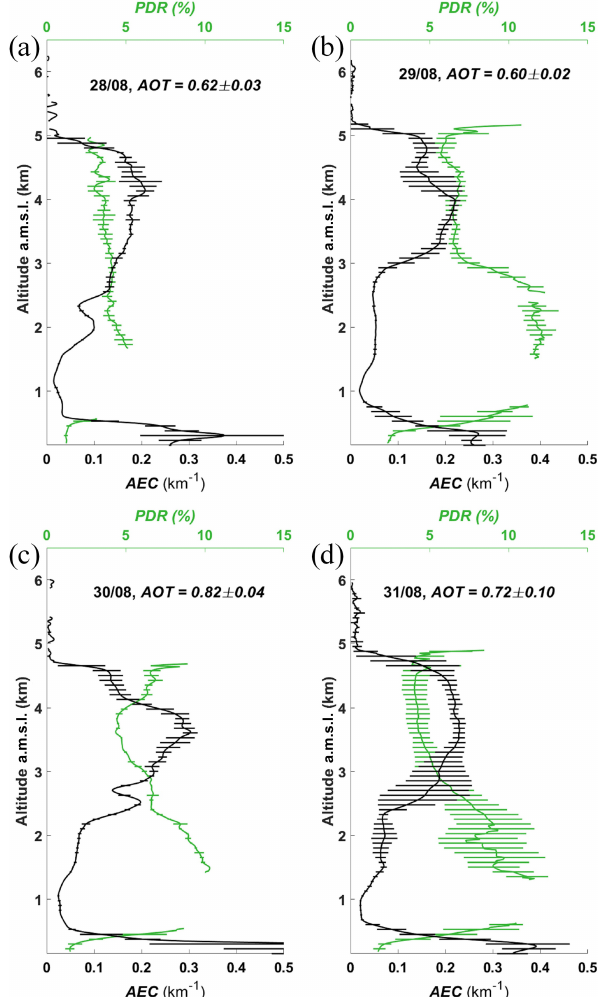
Figure 4. Vertical profiles of the AEC and PDR at 355nm with their uncertainties (horizontal bars) for period P 2 on (a) 28 (10:30– 12:30UTC), (b) 29 (17:30–22:50UTC), (c) 30 (18:00–20:00UTC) and (d) 31 (14:30–21:00UTC) August 2017. The total AOT at 355nm is also given for each profile with its uncertainty.